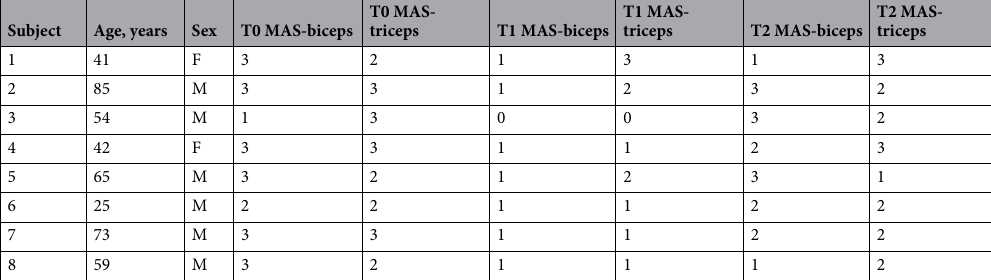
Table 2. Subgroup of patients injected with incobotulinum A toxin in